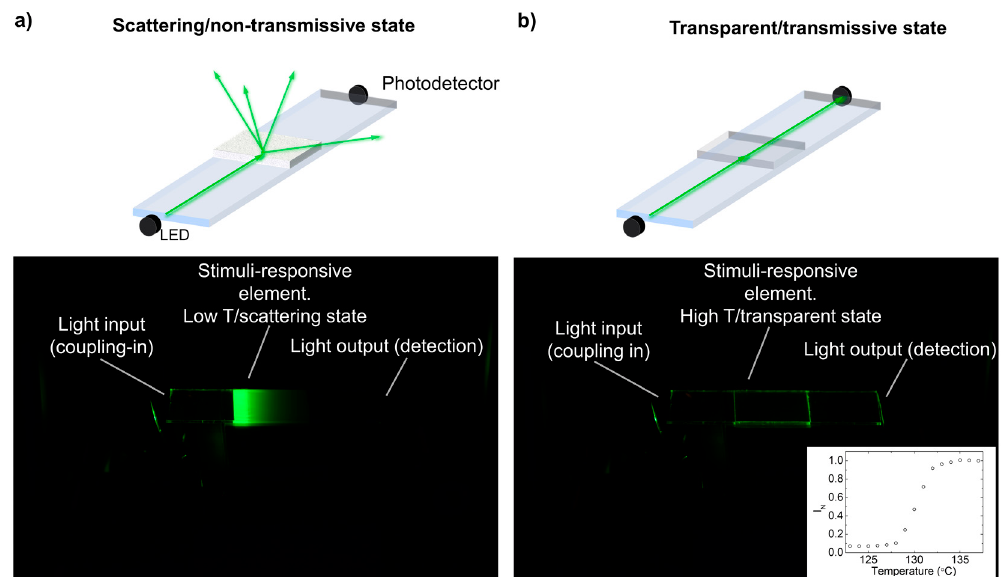
Figure 3. ( a ) and ( b ) Schematic representation (top) and photograph (bottom) of the optical planar waveguide sensor using a green LED (peak wavelength of 520 nm) to couple light into the waveguide at one of the waveguide extremes and a photodetector to measure transmitted light at the other extreme (a) in the scattering/non-transmissive state, at low temperature, and (b) in the transparent/transmissive state, at high temperature. The inset in (b) shows a plot of the green light intensity measured at the detection edge of the waveguide as a function of the temperature of the sensing area.